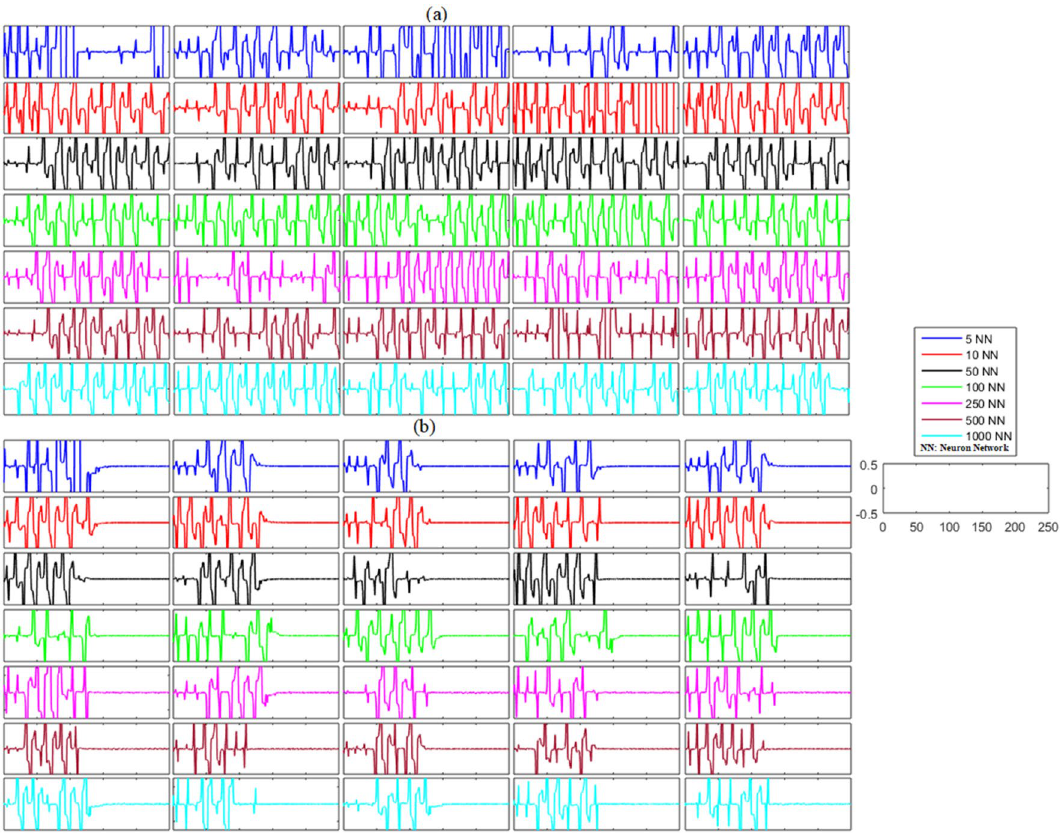
membrane potential states (x-state) of different time-delayed unidirectional FHN networks without